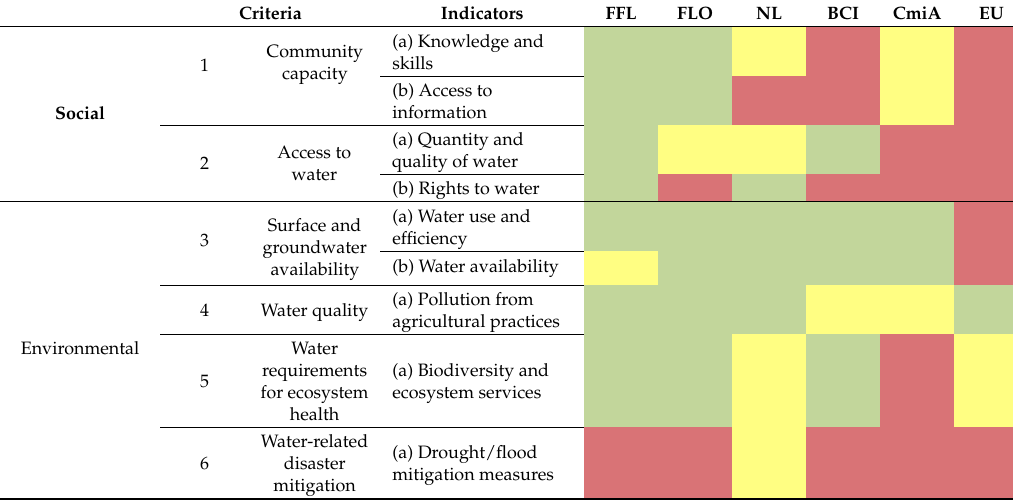
Table 2. Water sustainability in six cotton certification schemes. NL: Naturland.